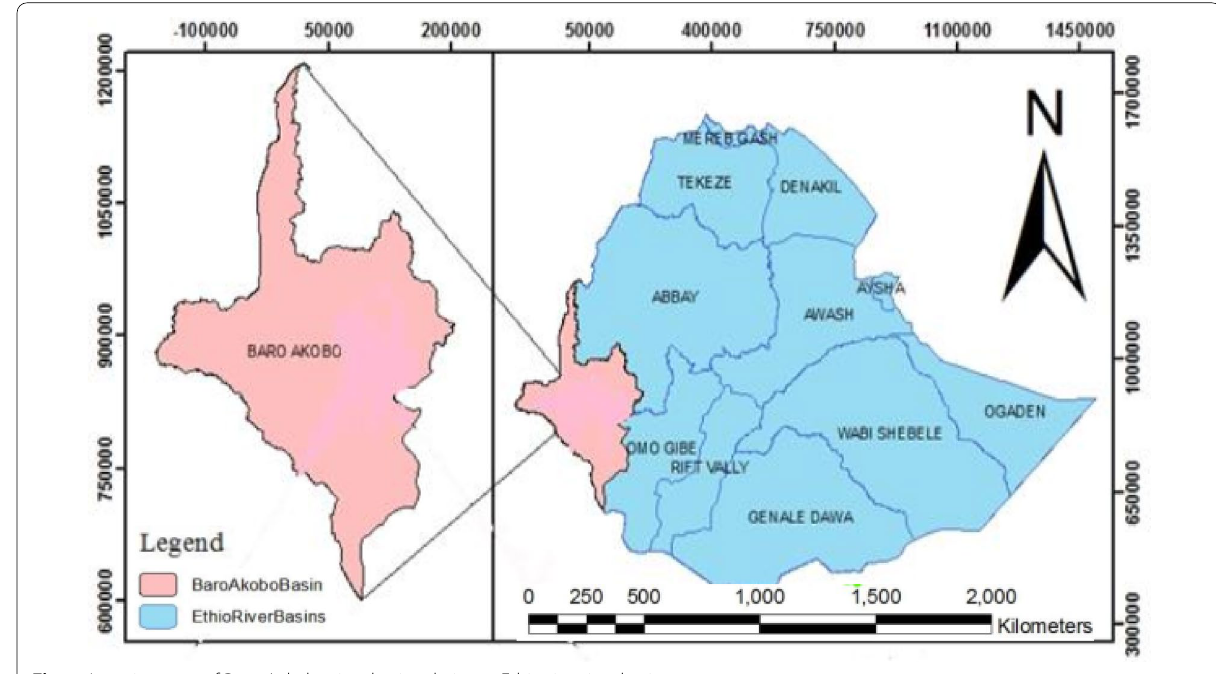
Fig. 1 Location map of Baro-Aakobo river basin relative to Ethiopian river